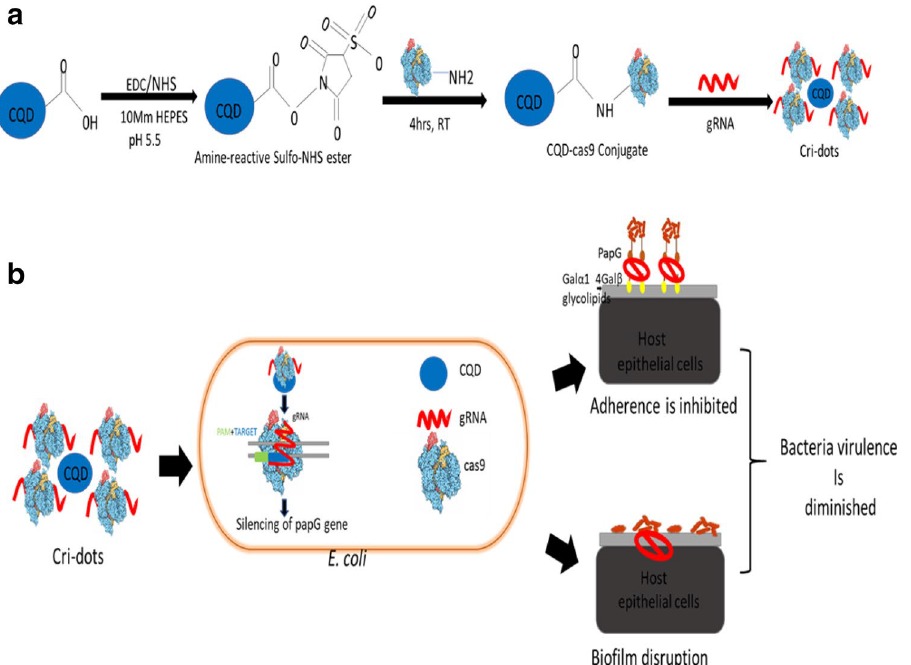
Figure 7. Overview of Cri-dots editing of papG in CFT073. ( A ) Schematic representation of amide bond formation between CQD and cas9 using EDC/Sulfo-NHS as a cross-linker to form a stable CQD-cas9 conjugate. ( B ) The representation of papG gene editing strategy through